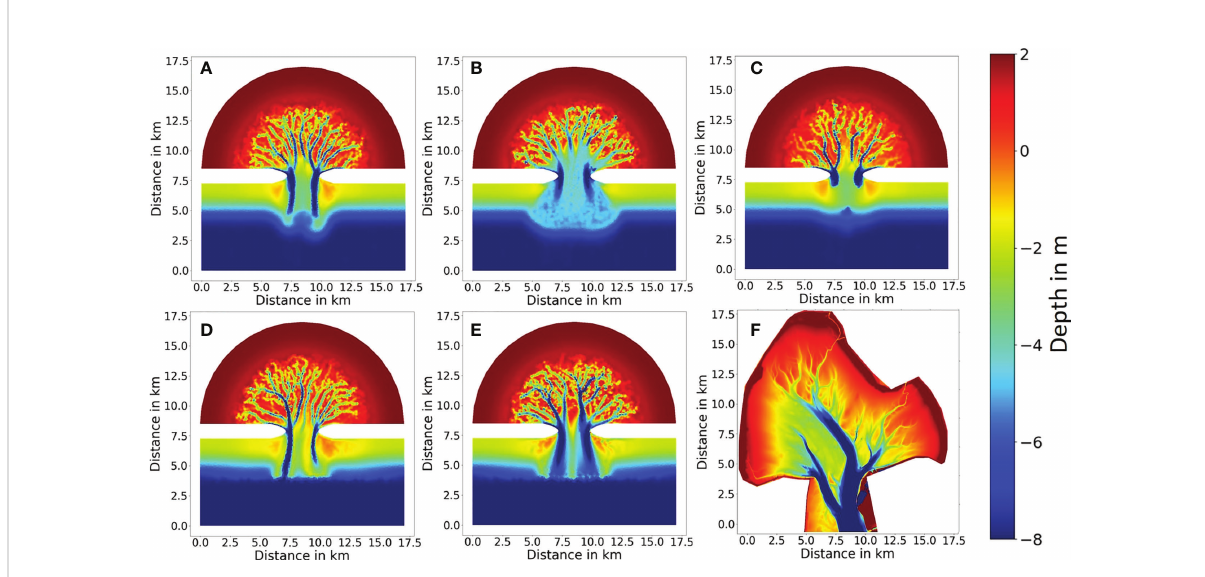
FIGURE 5 Simulated morphology at year 500 in (A) Reference run, (B) Bio_destabilization, (C) Bio_stabilization, (D) Bio_deposition, and (E) Bio-all. Bathymetry of a real tidal embayment (Jade Bay) is shown in (F) (data source: Sievers et al., 2020). Unit is m. Note that the belt-like deposition on the offshore side of the unerodible islands in all simulations is due to an exclusion of alongshore transport in the